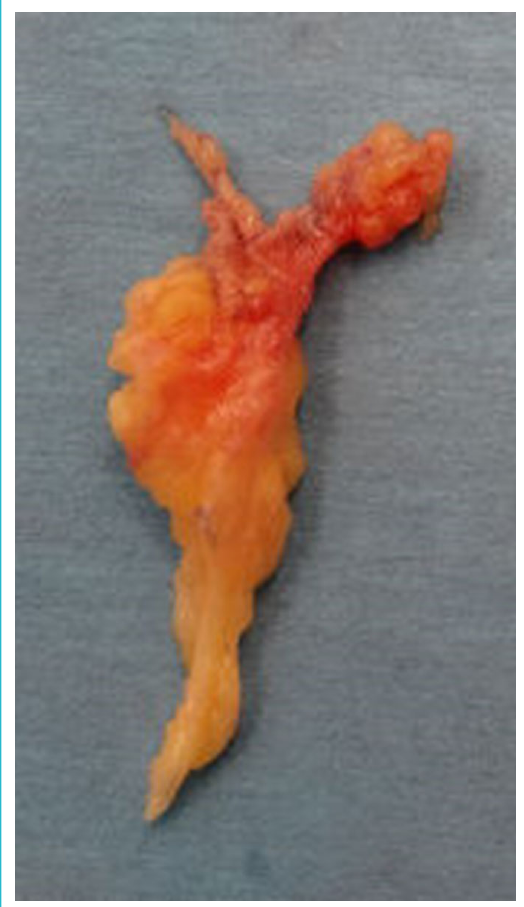
Figure 4: A Y resection of the digital nerve is carried out and the sample is sent for histopathological confirmation of the